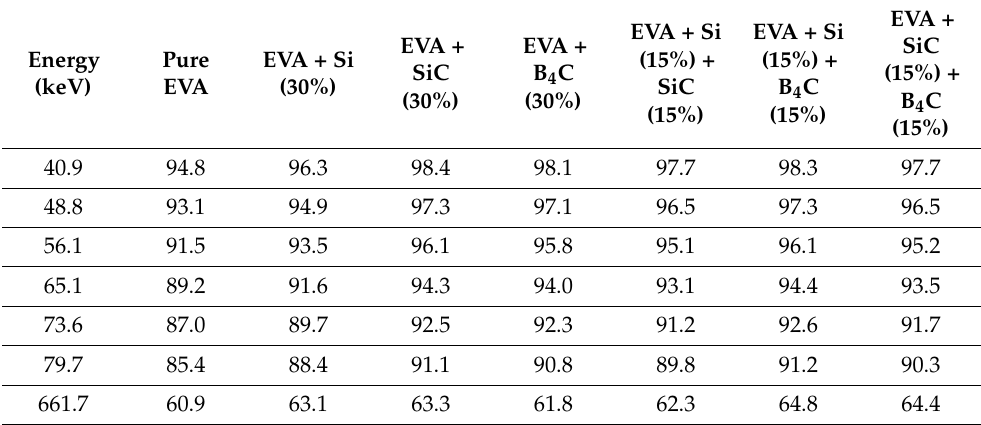
Table 3. Measured radiation protection efficiency (RPE) values, with incident energy of the studied samples.